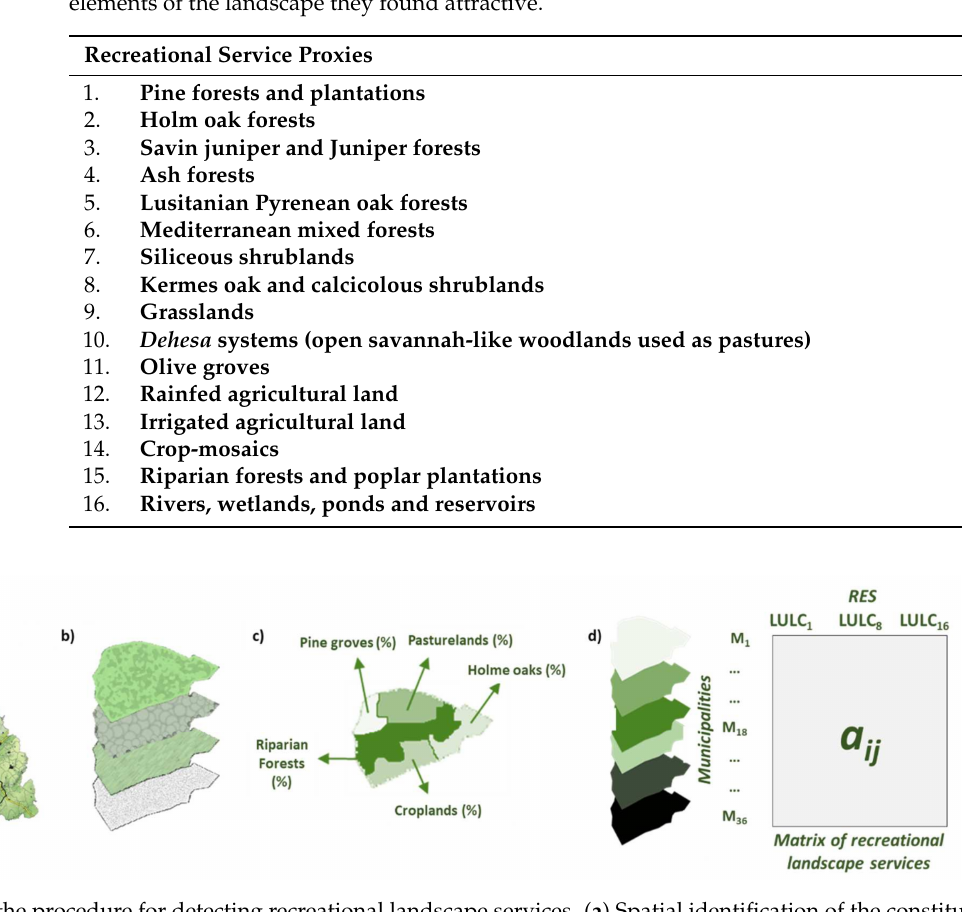
Table 1. LULCs used as proxies for recreational and nature-based tourism ecosystem services (RES) supplied by the landscape. LULCs were quantified as a percentage of occupied area in each municipality of the rural-urban gradient. These proxies were also questions in a survey on landscape preferences of visitors to the gradient studied. In this survey, visitors qualitatively indicated which elements of the landscape they found attractive.